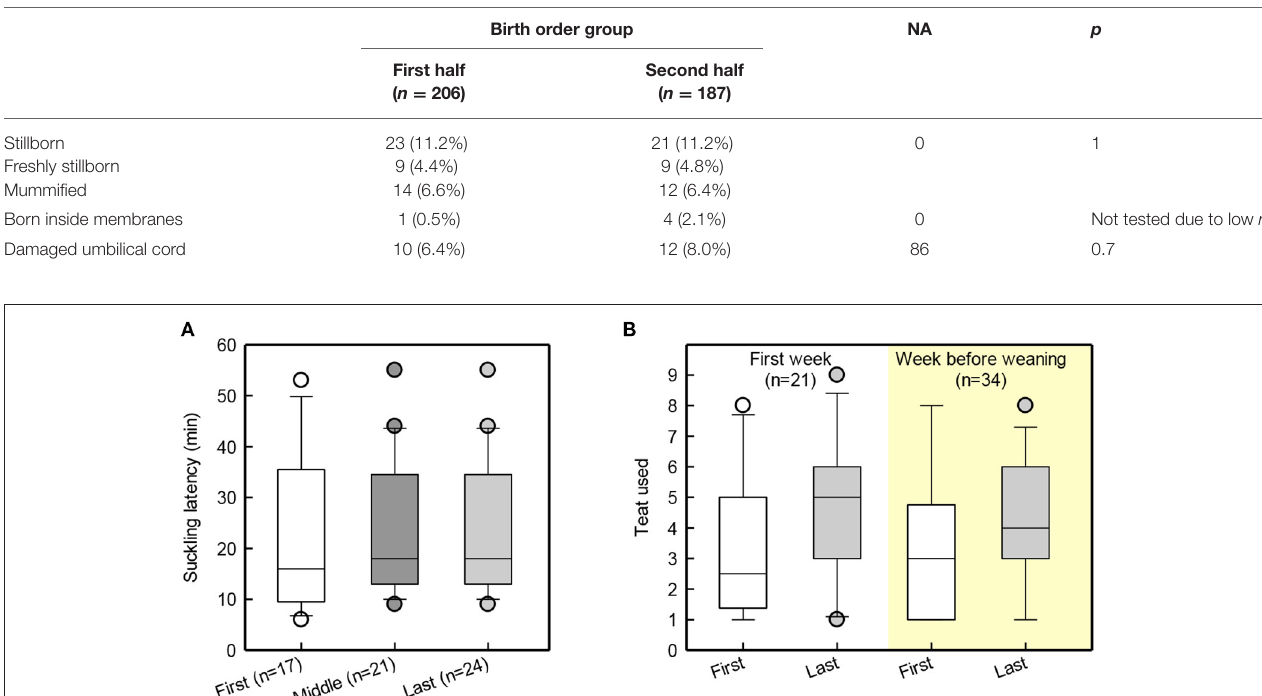
TABLE 3 | Prevalence of stillbirths, births inside membranes and damaged umbilical cords.